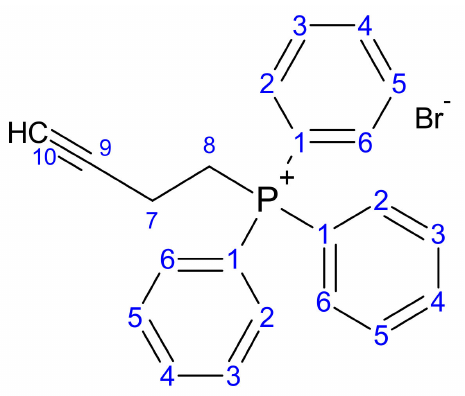
Figure 4. Structure of but-3-yn-1-yl (triphenyl phosphonium) bromide (1).